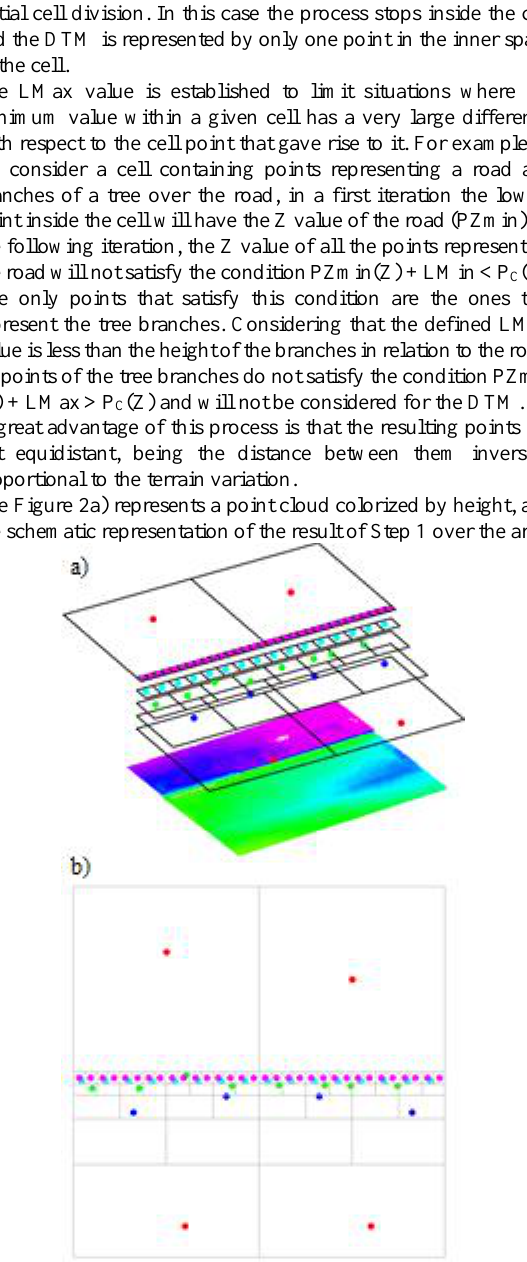
Figure 2. a) Perspective view of a colored point cloud and cells with the corresponding points inside; b) Top view of the cells and selected